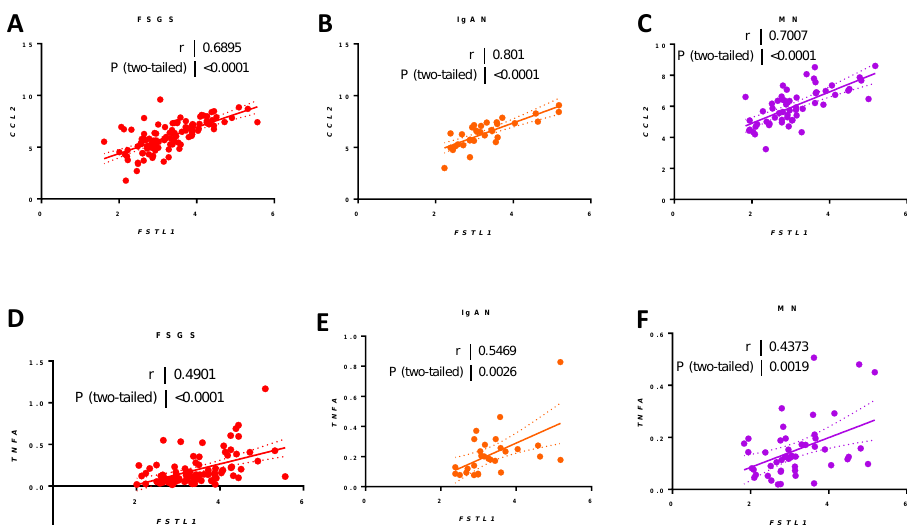
Figure 25. Relationship of FSTL1 mRNA Levels to the Expression of Genes Implicated in Inflammation in FSGS (red), IgAN (orange), and MN (purple). CCL2 expression correlated to FSTL1 mRNA levels in FSGS ( A ), in IgAN ( B ), and MN ( C ). TNFA expression correlated to FSTL1 mRNA levels in in FSGS ( D ), in IgAN ( E ), and MN ( F ). Pearson’s correlation coefficient ( r ) with two-tailed p values were calculated. Significance was determined as a p value of <0.05. Linear regression generated the line of best fit (solid lines) with 95% confidence intervals (dotted lines).